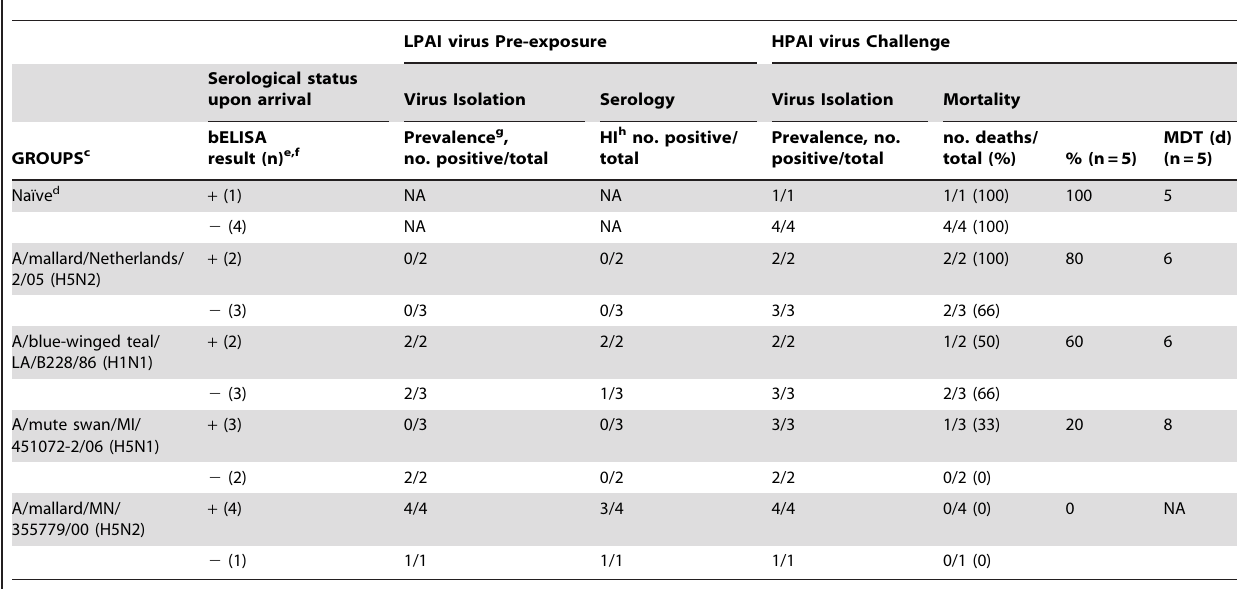
Table 1. Serological status before and after the experimental low pathogenicity avian influenza (LPAI) virus exposure, virus isolation data, and mortality of wood ducks ( Aix sponsa ) experimentally inoculated a with different subtypes of LPAI viruses and subsequently challenged with the highly pathogenic avian influenza (HPAI) virus A/whooper swan/Mongolia/244/05 (H5N1) b